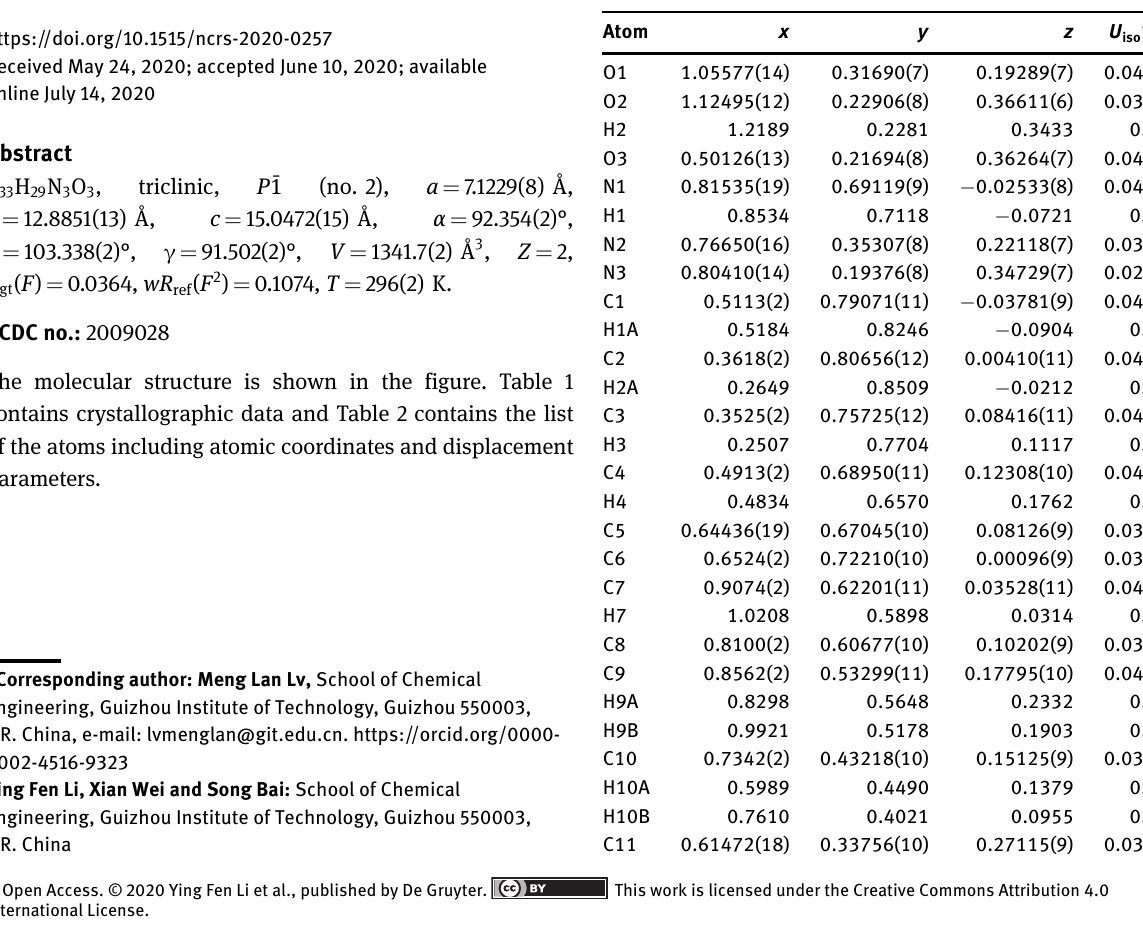
Table 2: Fractional atomic coordinates and isotropic or equivalent isotropic displacement parameters (Å 2